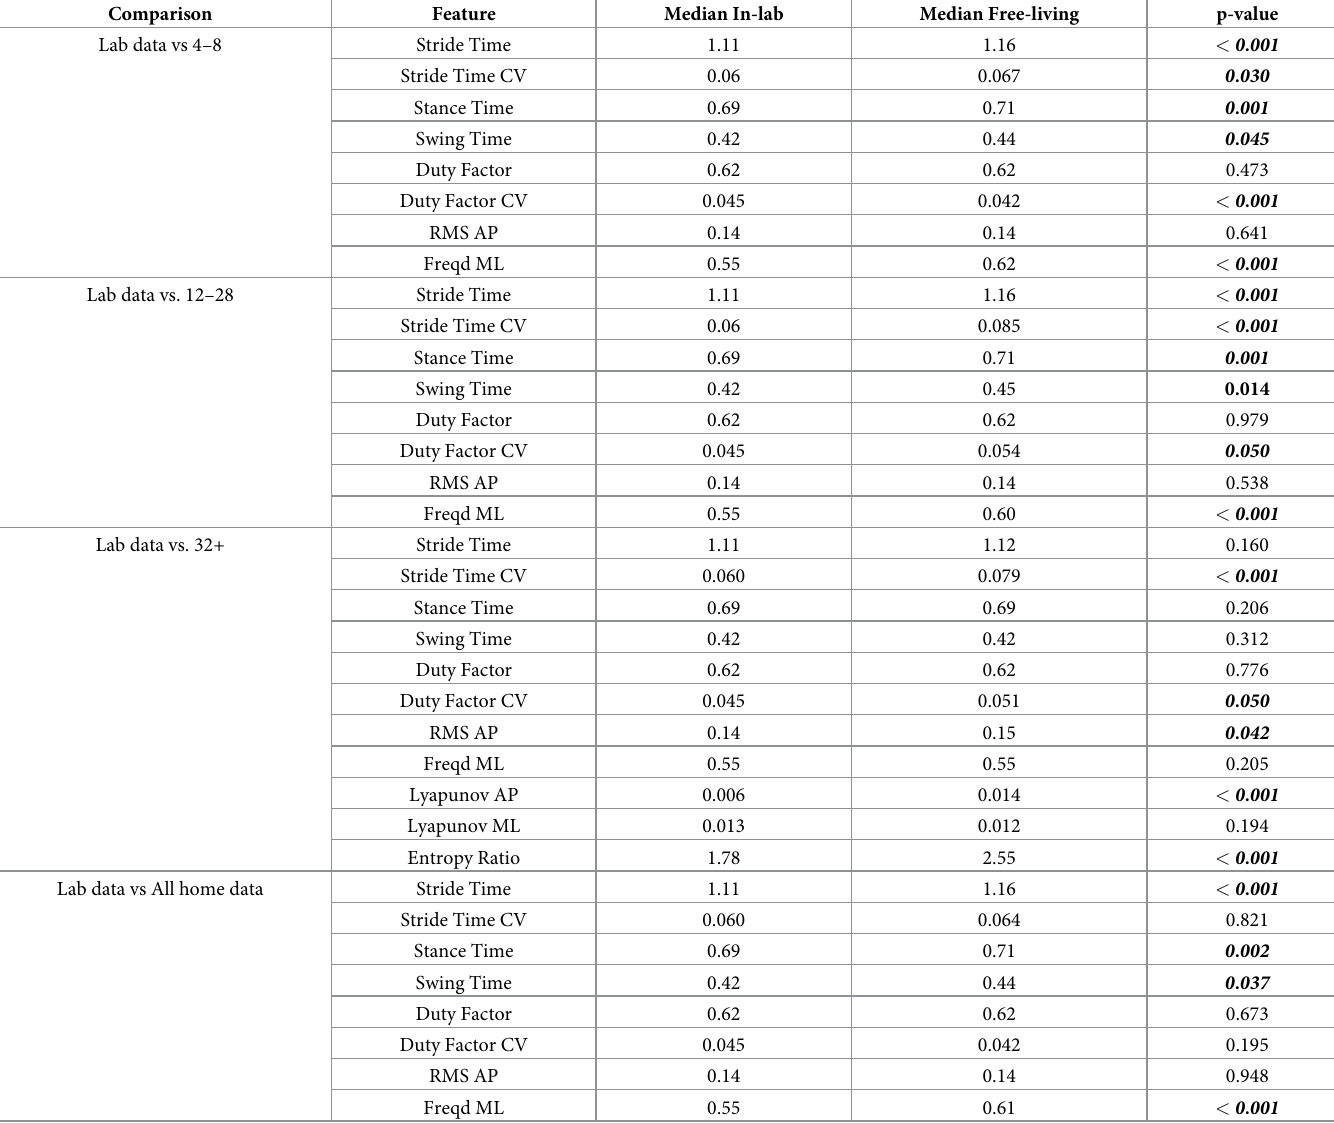
p g, and Duty Factor is unitless. All p-values found using a rank sum test using a